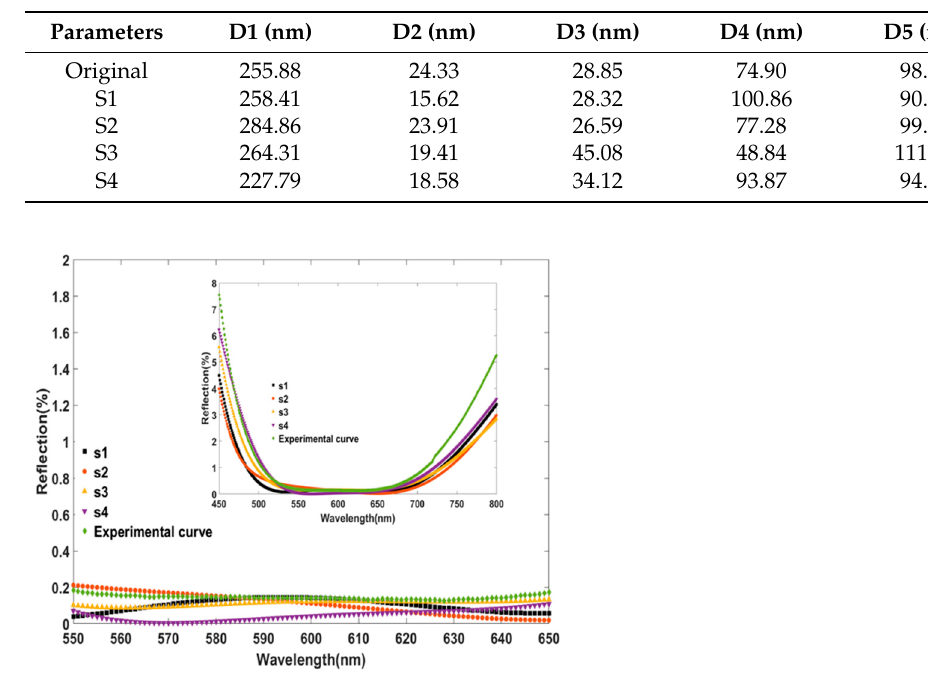
Figure 9. The reflection spectra of various structures inversely designed for the 550~650 nm wave- length range.